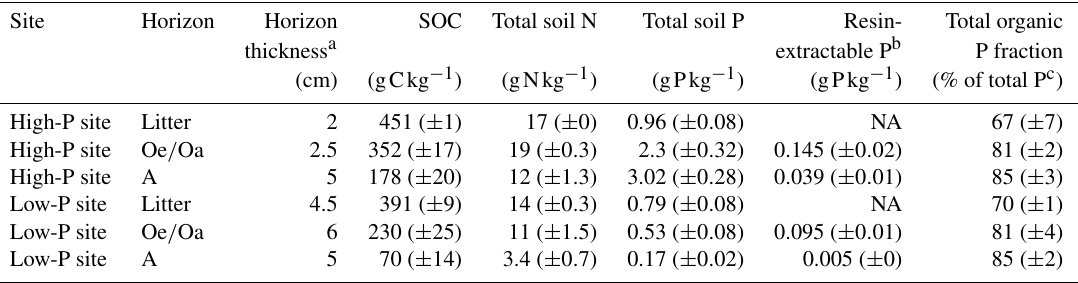
Table 1. Soil organic carbon (SOC), total soil nitrogen (N), and total soil phosphorus (P) concentrations in litter, Oe / Oa, and A horizons from the control treatment (unfertilized) at the high-P and the low-P site. Samples were taken in July 2019; values represent means ± standard error of three field